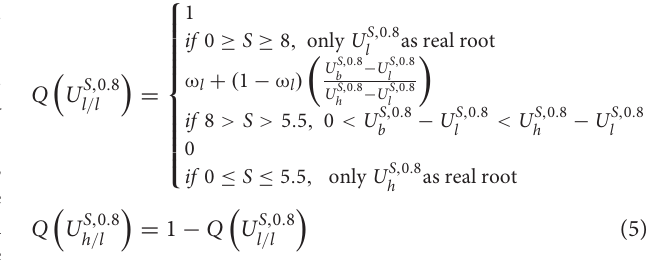
the cryptic urchin (lower) arm of the α = 0.8 isocline of Figure 2 . In the full resilience zone ( S ≥ 8), perturbations from that equilibrium always return to the cryptic equilibrium. In the zero-resilience zone ( S ≤ 5 . 5) the cryptic equilibrium does not exist. Instead, there is a fully resilient urchin barren. In the partial resilience zone (8 > S > 5 . 5), perturbations from the cryptic equilibrium are non-negative and bounded by the two stable equilibria. Assuming that perturbation outcomes from a cryptic urchin equilibrium in the partial resilience zone land at the originating equilibrium with a probability of (cid:16) , 0 . 8 ω U S l , or follow a uniform distribution, u l a probability 1 − ω l , the probabilistic resilience for ending up on the lower arm versus upper arm equilibrium is given by Eq.